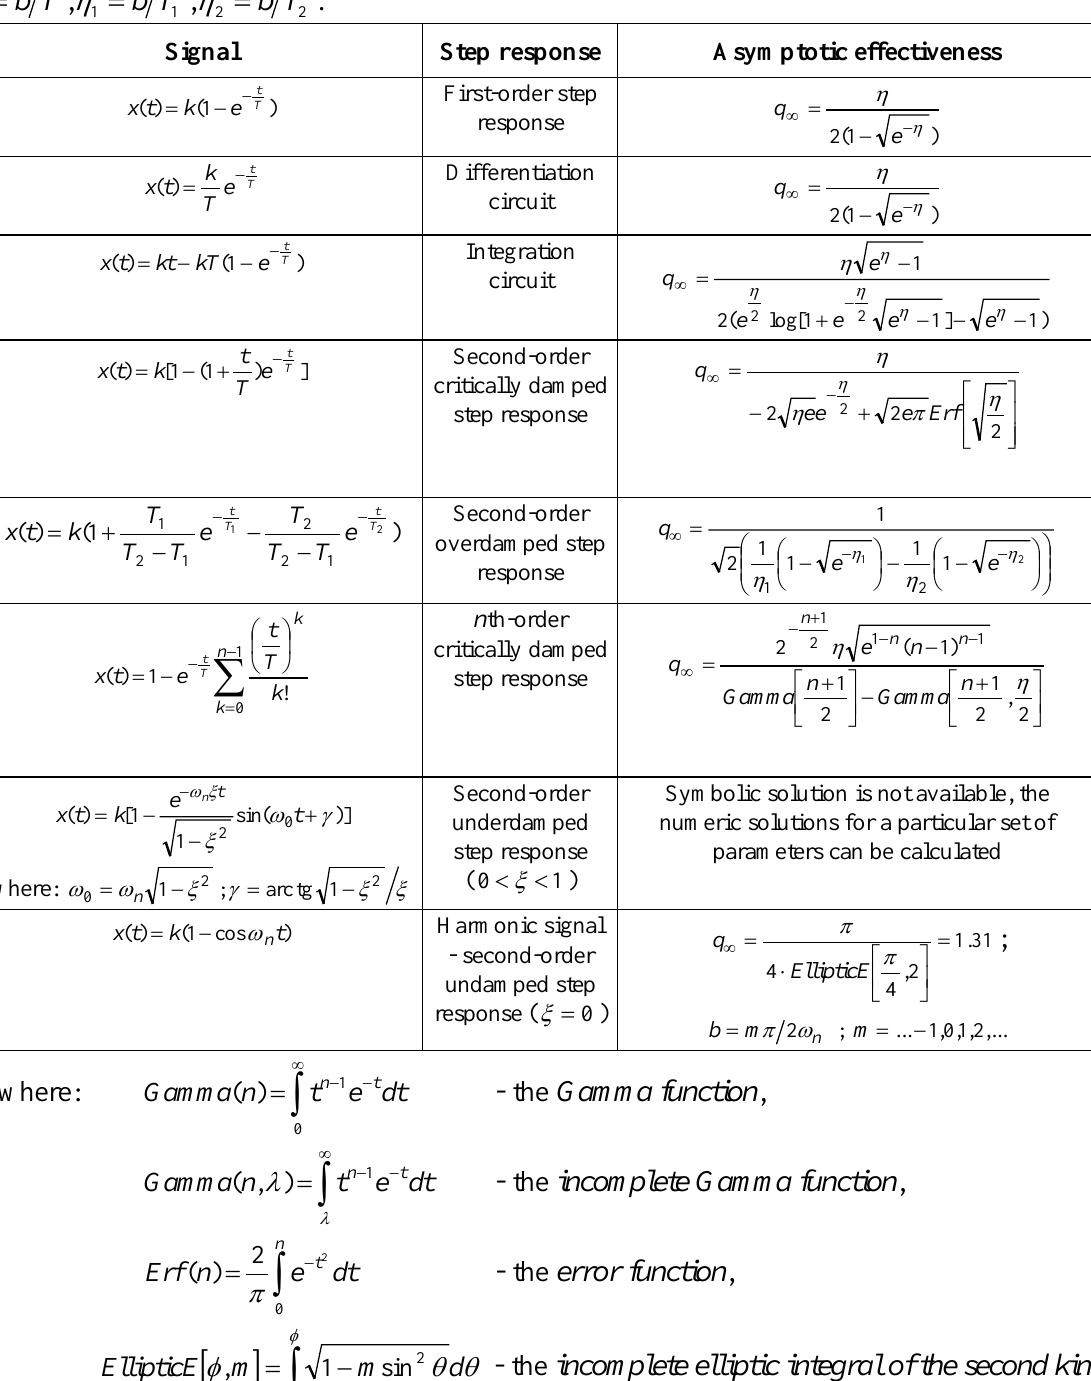
Table 3 . The event-based integral sampling asymptotic effectiveness for some time responses of the first and the second-order dynamic systems calculated for the time interval ],0[ b ,